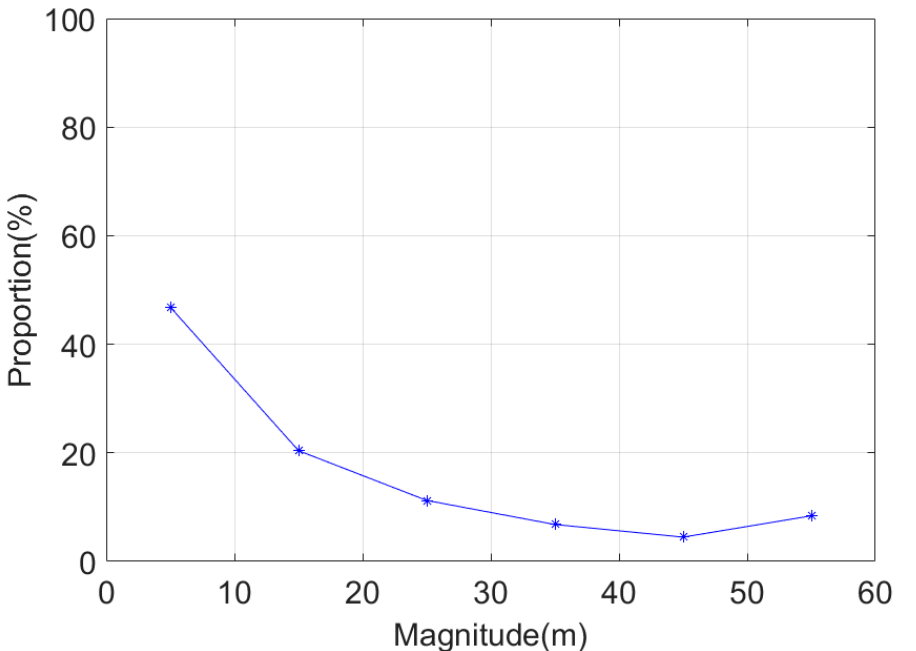
Figure 10. Points proportion with an improvement of 0~10 m, 10~20 m, 20~30 m, 30~40 m, 40~50 m, and >50 m.